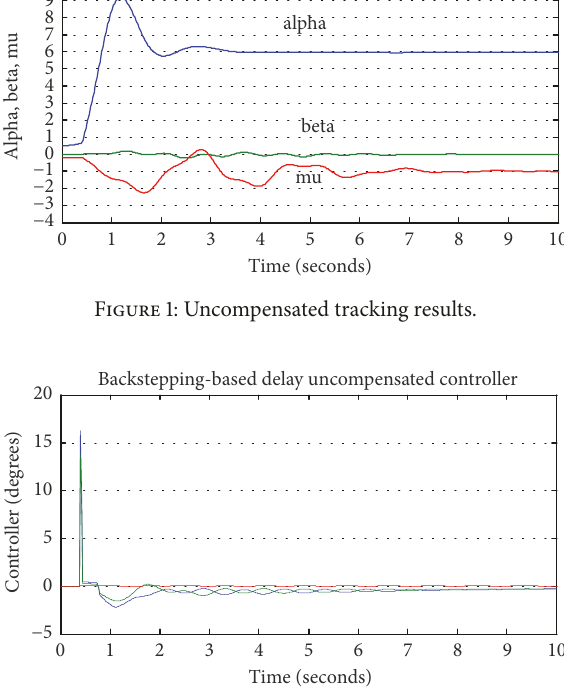
Figure 2: Uncompensated actuator deflections.